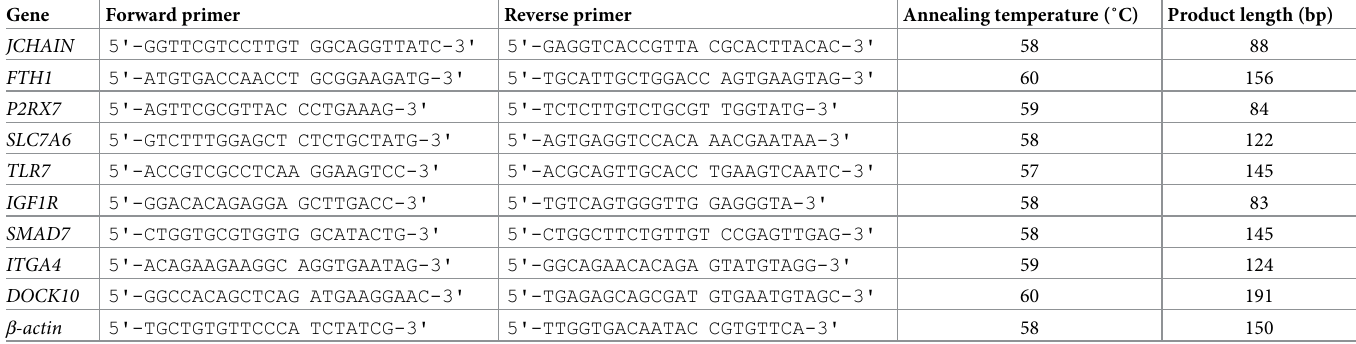
Table 2. qPCR primer design of immune-related differentially expressed genes.